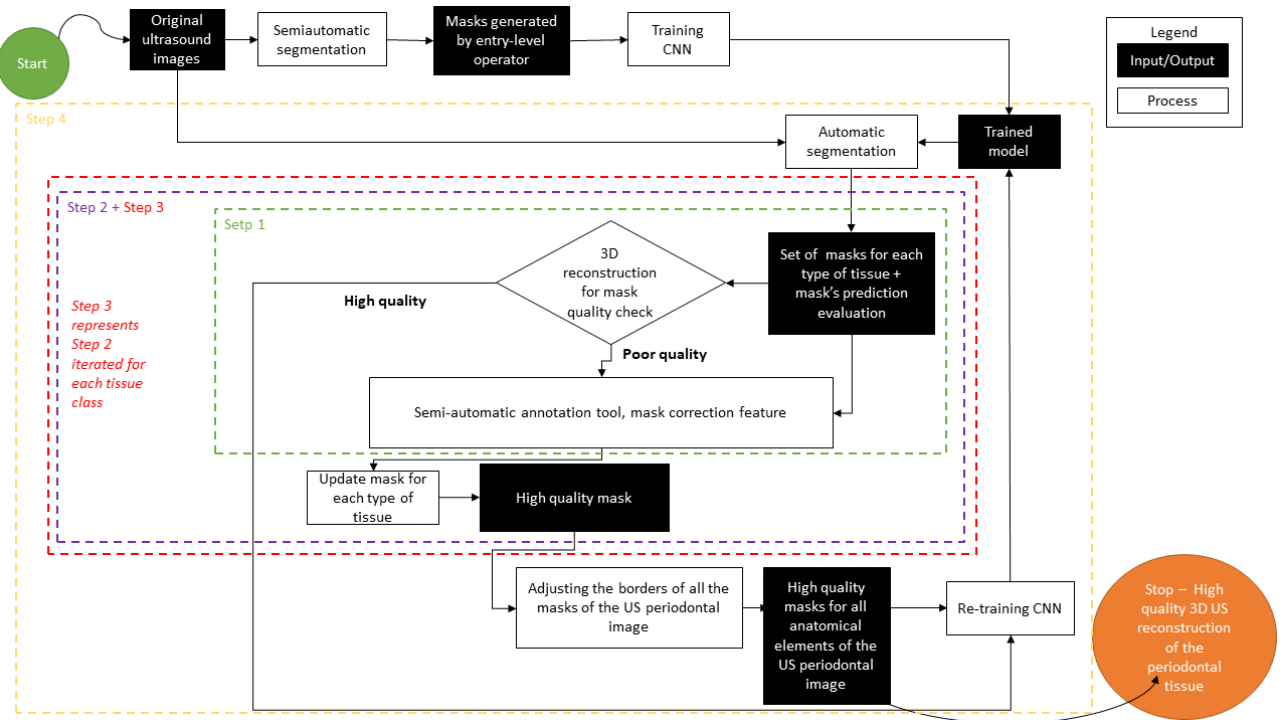
Figure 1. Mask generation process and quality check in the 3D space.